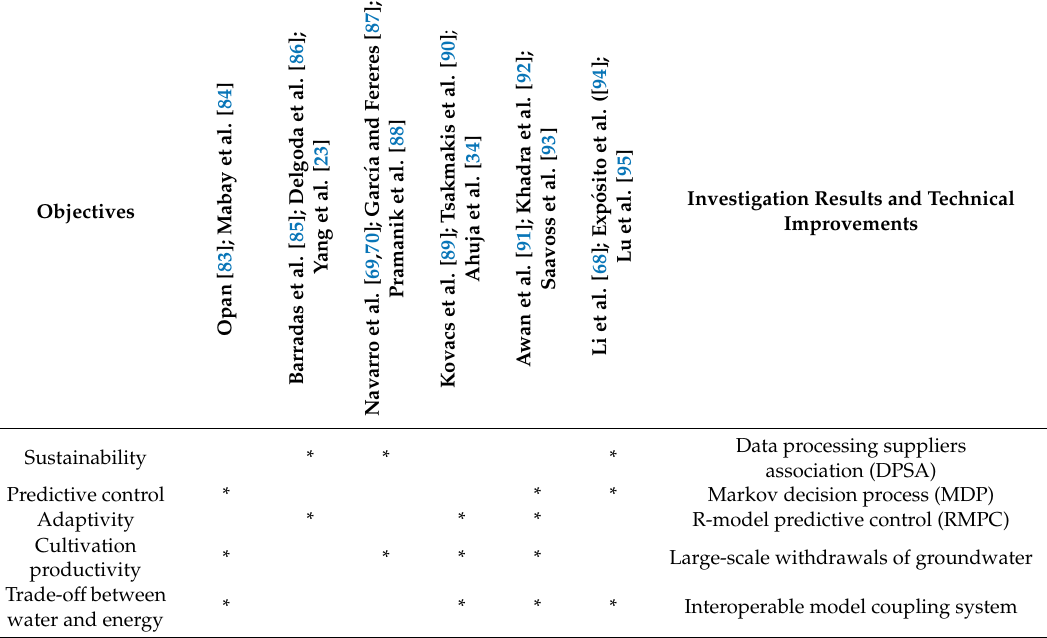
Table 2. Key influential factors in integrative management e ff ectiveness in precision